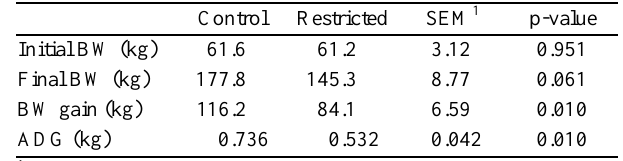
Table 3. Average daily feed intake per calf during the feeding trial Table 4. Body weight changes in Hanwoo calves